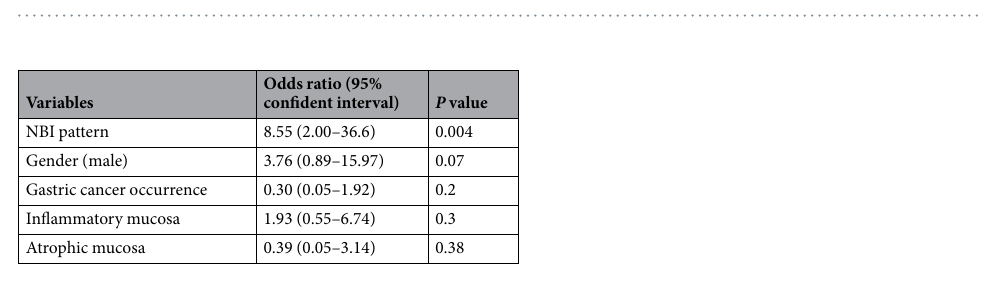
The clustering analysis of CGI and NCGI, dividing sites into promoter (PCGI: n = 1653 and NPCGI: n = 20222) and outside promoter (PNCGI: n = 2573 and NPNCGI: n = 34717) all distinguished normal and type 1, 2, and 3 patterns (Fig. S2a–d). In detail, the change of mucosal patterns from normal to types 1, 2, and 3 was associated with hyper- methylation in PCGI, NPCGI and NPNCGI (Fig. S2a,b,d), while the analysis of PNCGI showed that the methyla- tion was increased from types 2, 1 and normal and type 3 (Fig. S2c). Next, we further focused the analysis on PCGI methylation because of its influence on gene expression. Through the clustering analysis of PCGIs, we identified